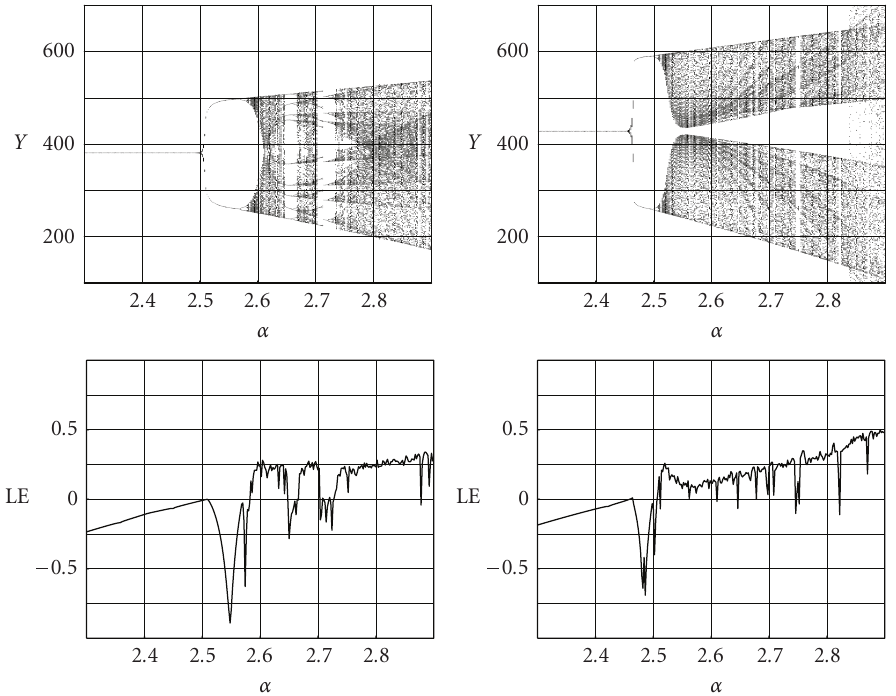
Figure 7.2. Bifurcation diagram of Y and Lyapunov exponent for model 2, β = 0 . 5 (left) and β = 0 . 8 (right).